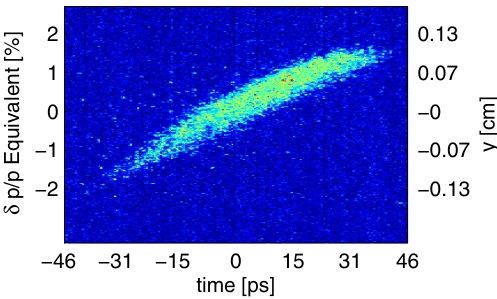
FIG. 3. The raw streak camera data after the dipole as mea- sured using an aerogel screen and a Hamamatsu C5680 streak camera.